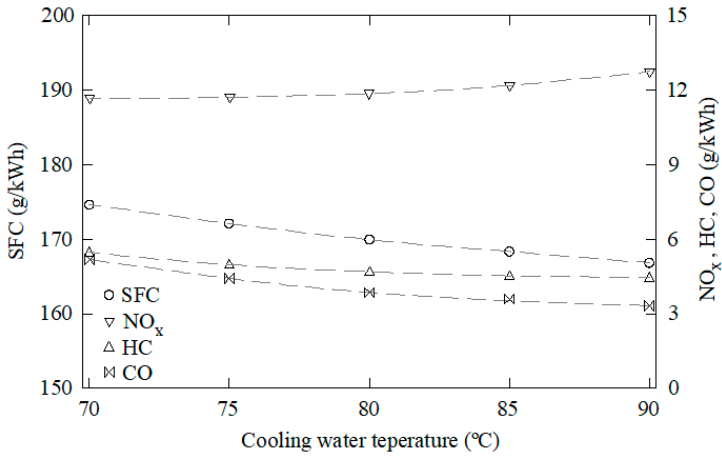
Figure 7. SFC, NO x , CO, and HC emissions against the cooling water temperature. EGR rate = 0, water to fuel ratio = 0, overlap timing = 96°, intake valves closing = 568°.